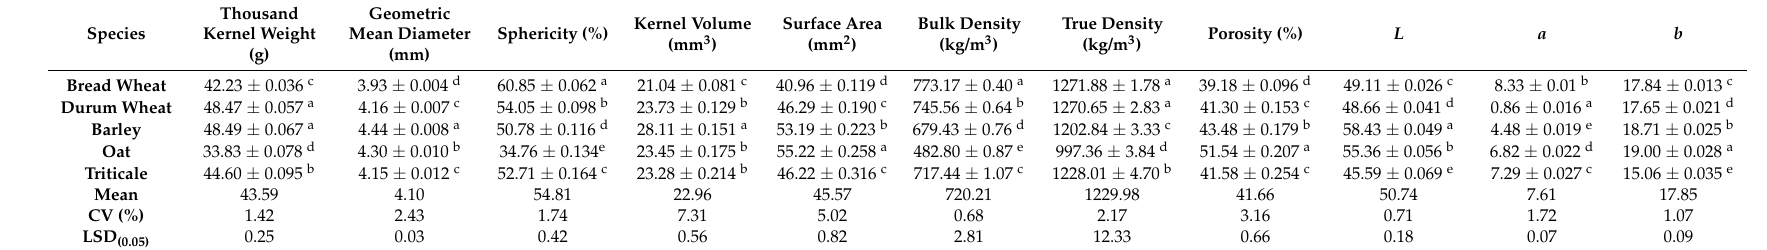
Table 2. The mean and standard deviation values of the physical properties of the grain